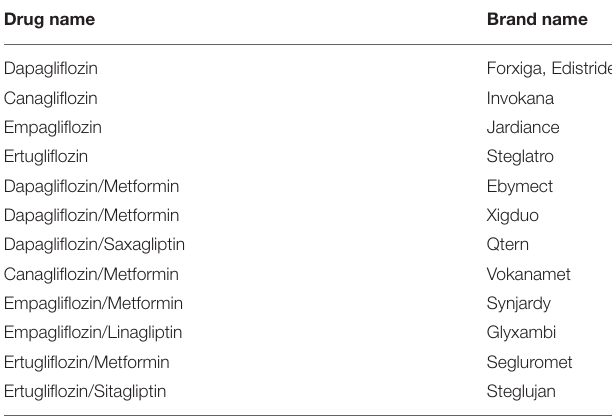
TABLE 1 | List of SGLT2 inhibitors currently licenced for use in the UK according to the NICE clinical guidelines. Drug name